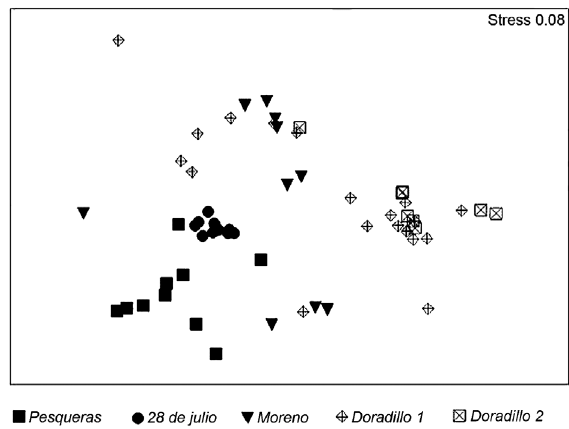
Fig . 3. – Multidimensional scaling diagram (nMDS) for the collec- tion sites on sandy intertidal beaches of Puerto Madryn. Table 2. – R-statistic values and significance levels (between brackets) in pairwaise comparisons among sites using the ANOSIM test. Significant differences in bold characters.